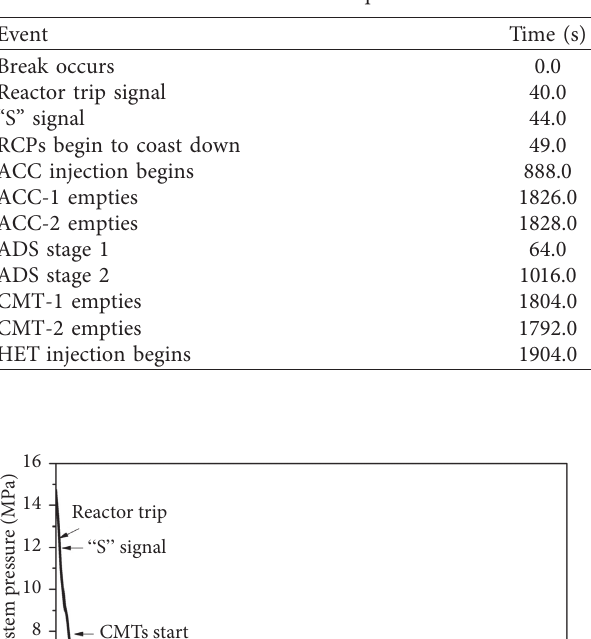
Table 4: 2-inch SBLOCA transient sequence of the accident.